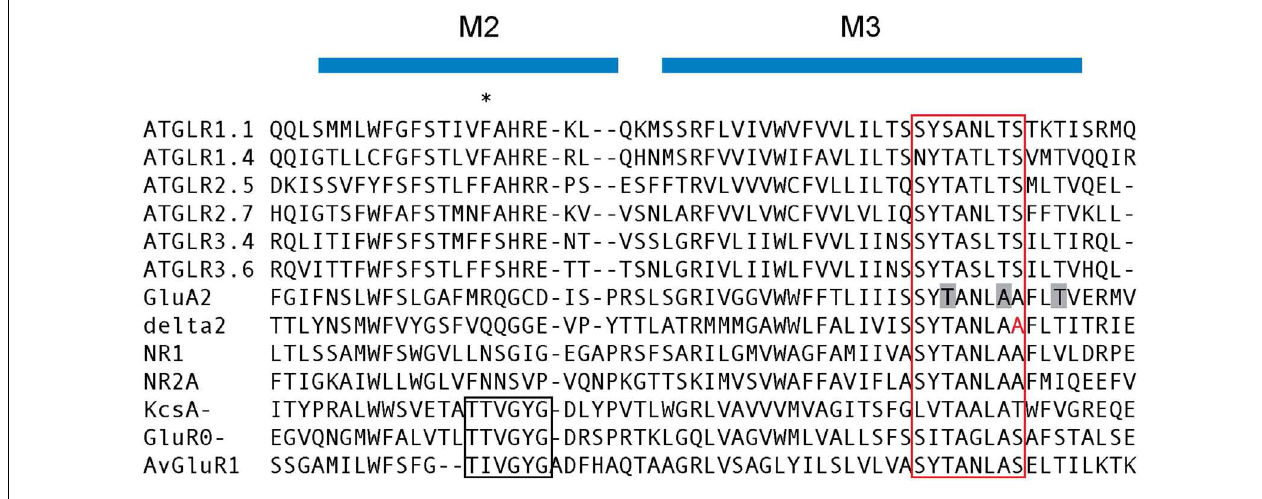
marked by a box. AGI and Genbank accession numbers: ATGLR1.1, at3g04110; ATGLR1.4, at3g07520; ATGLR2.5, at5g11210; ATGLR2.7, at2g29120; ATGLR3.4, at1g05200; ATGLR3.6, at3G51480; GluA2 ( Rattus norvegicus ), NP_000817.2; delta2 ( Mus musculus ), NP_032193.1 ; NR1 ( Homo sapiens ), NP_015566.1; NR2A ( Rattus norvegicus ), NP_036705.3; KcsA ( Streptomyces lividans ), P0A334.1; GluR0 ( Synechocystis sp . PCC 6803 ), ZP_06526299.1; AvGluR1 ( Adineta vaga ),